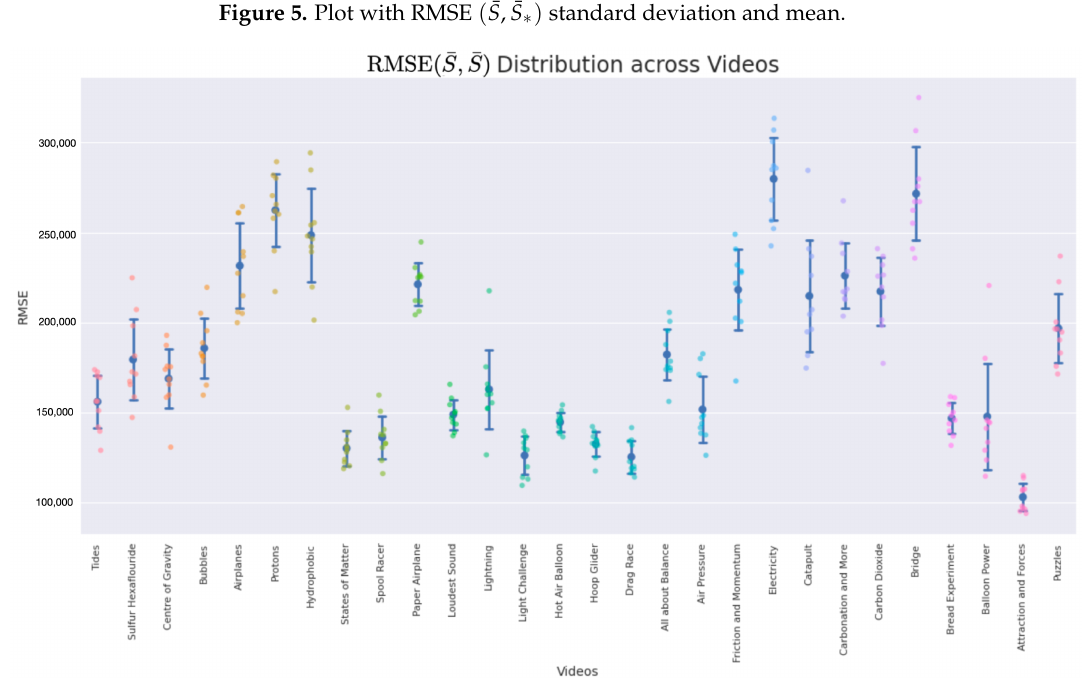
Figure 5. Plot with RMSE ( ¯ S , ¯ S